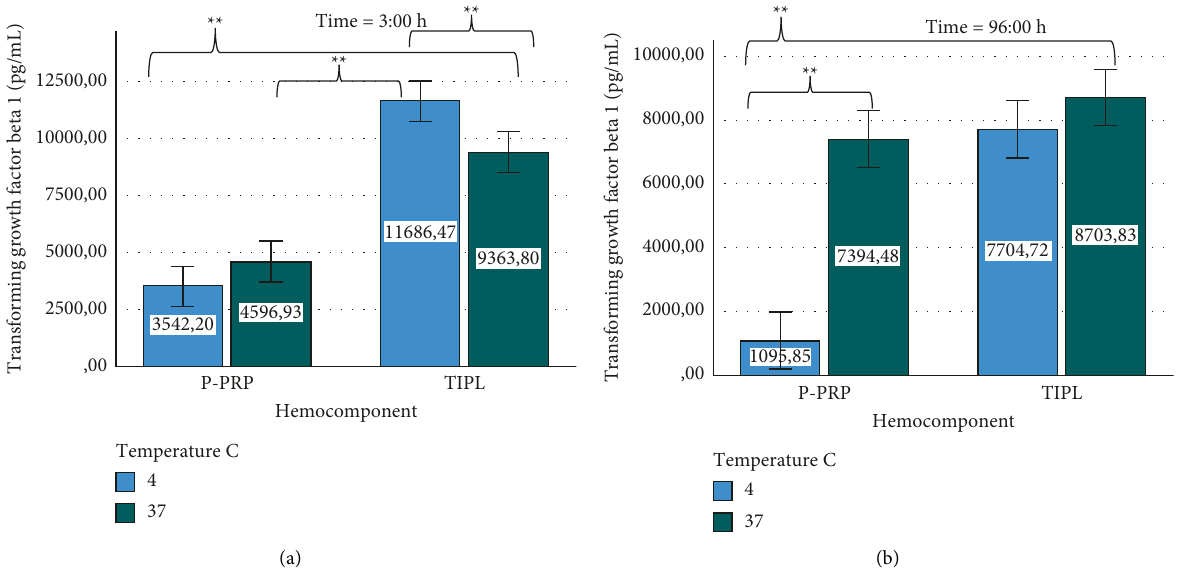
Figure 5: Mean ± sd transforming growth factor beta 1 concentration in hemocomponents affected by time and temperature. (a) Transforming growth factor beta 1 at 3h. (b) Transforming growth factor beta 1 at 96h ∗∗ denotes significant ( P < 0 . 005) differences for both hemocomponents by the Games–Howell post-hoc